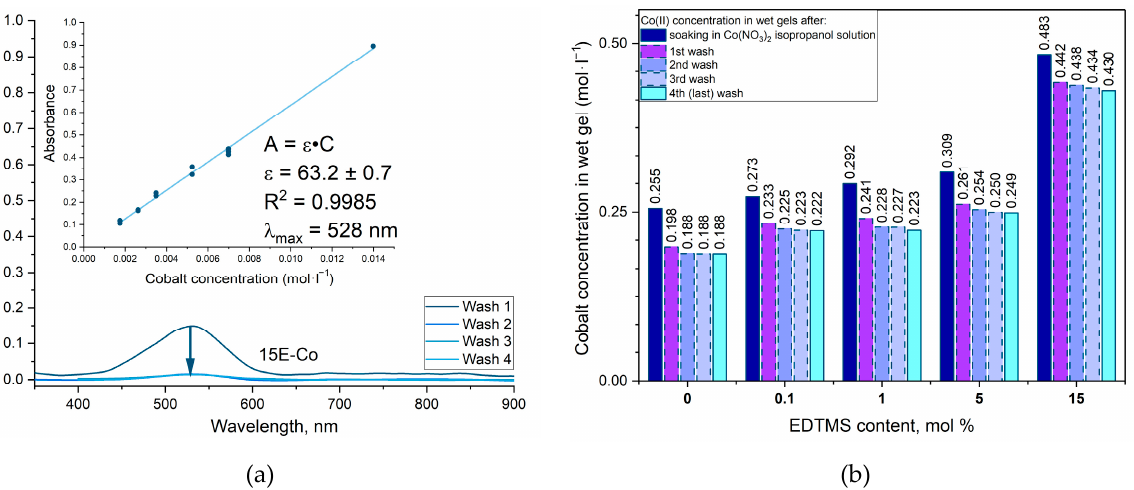
Figure 1. ( a ) Cobalt content in 15E-Co wet gel after washing with isopropanol, showing the UV-vis absorbance spectra of washing liquors. Inset: UV-vis absorbance calibration curve of cobalt(II) nitrate isopropanol solutions. ( b ) Changes in cobalt(II) content in the wet gels after washing with isopropanol, as assessed using UV-vis spectroscopy of the initial solutions and the washing